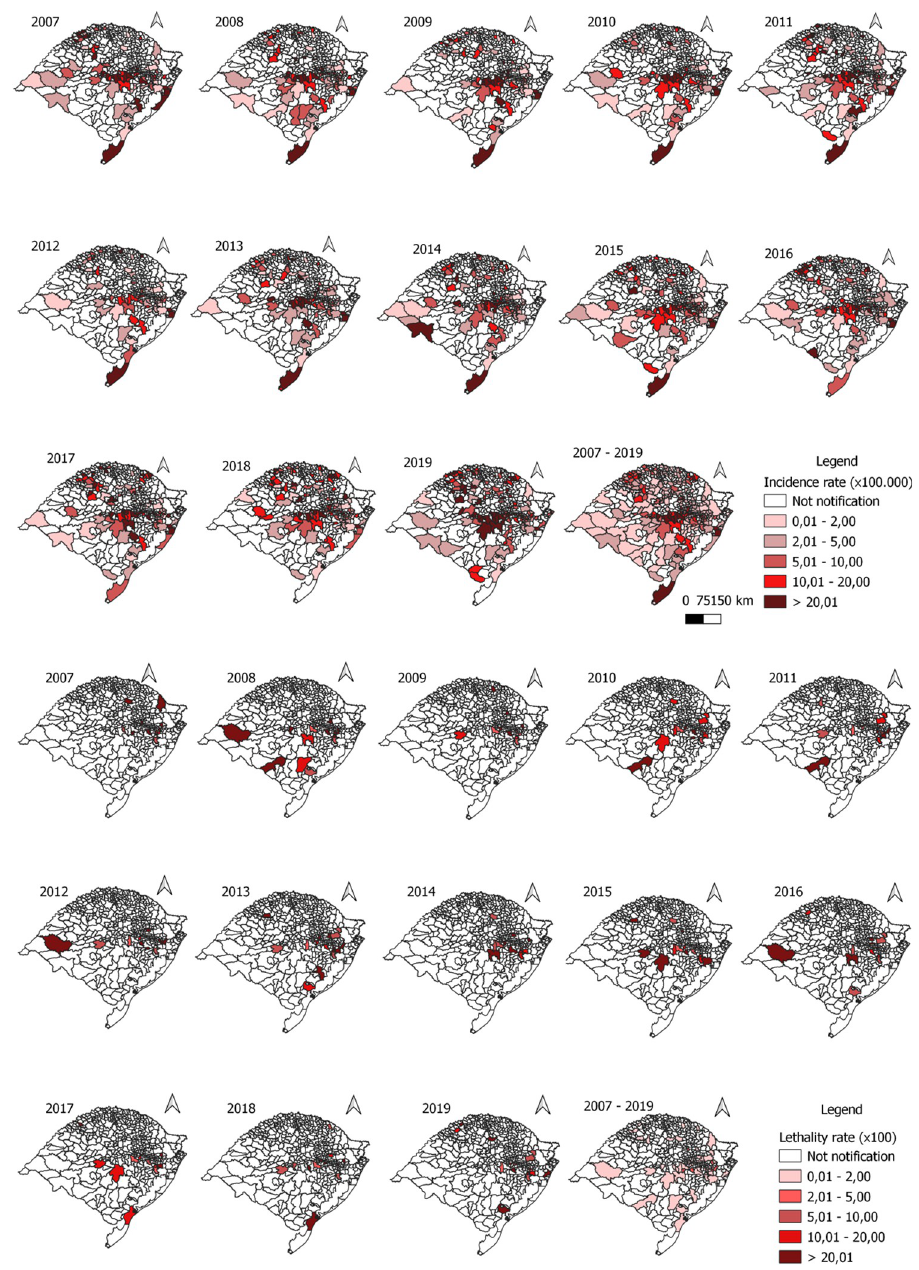
Fig 2. Spatial distribution of leptospirosis incidence and lethality rate in Rio Grande do Sul municipalities, Brazil, from 2007 to 2019 (incidence rate: cases/100,000 inhabitants; lethality rate: %). the year 2020 and the prediction interval (black bars) (Fig 5). The model considered the 12-month seasonal pattern and predicted a decrease in incidence in 2020 (Fig 5).